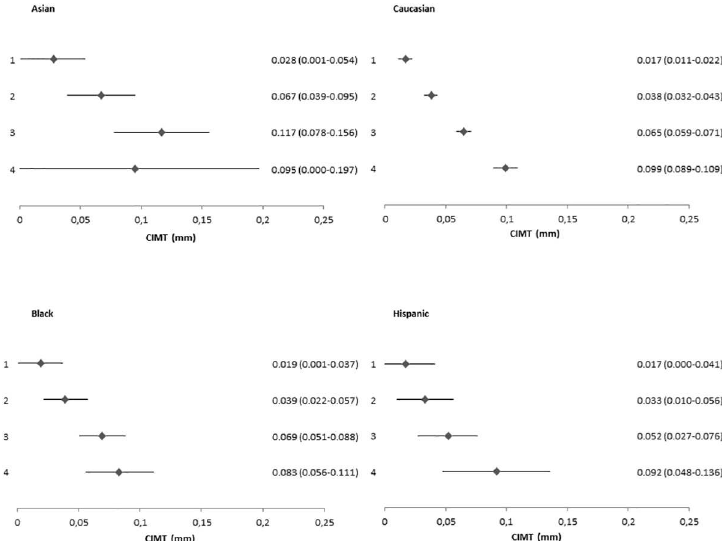
Fig 2. Relation between numbers of risk factors and differences in CIMT by race-ethnic group. Each number of risk factors was compared to individuals without any risk factor (referencegroup). CIMT, mean common carotid intima media thickness. Fig 3 presents the main findings of the overall analysison risk factor clusters and CIMT. Within each risk factor cluster, there were gradedrelationswith common CIMT. Within those with two risk factors, the cluster blood pressure-smoking had the highestCIMT (mean difference of 0.077 mm with those without risk factors) and the cluster with overweight- total cholesterol the least thickening(mean difference of 0.039 mm with those without risk factors), a difference reachingstatistical significancewith the cluster since the 95 confidencelimits did not overlap. For peoplewithin the three risk factor cluster, elevated blood pressure, overweight and smoking had the highest common CIMT (0.084 mm). The pattern of the relationship betweenrisk factor clusters and common CIMT were similar betweensexes and race-ethnic groups, although some variationwas observedbetweenrace-ethnicgroupsbut was not significantdue to limited minority samples sizes (S1 and S2 Figs). The interactionterms were not statistically